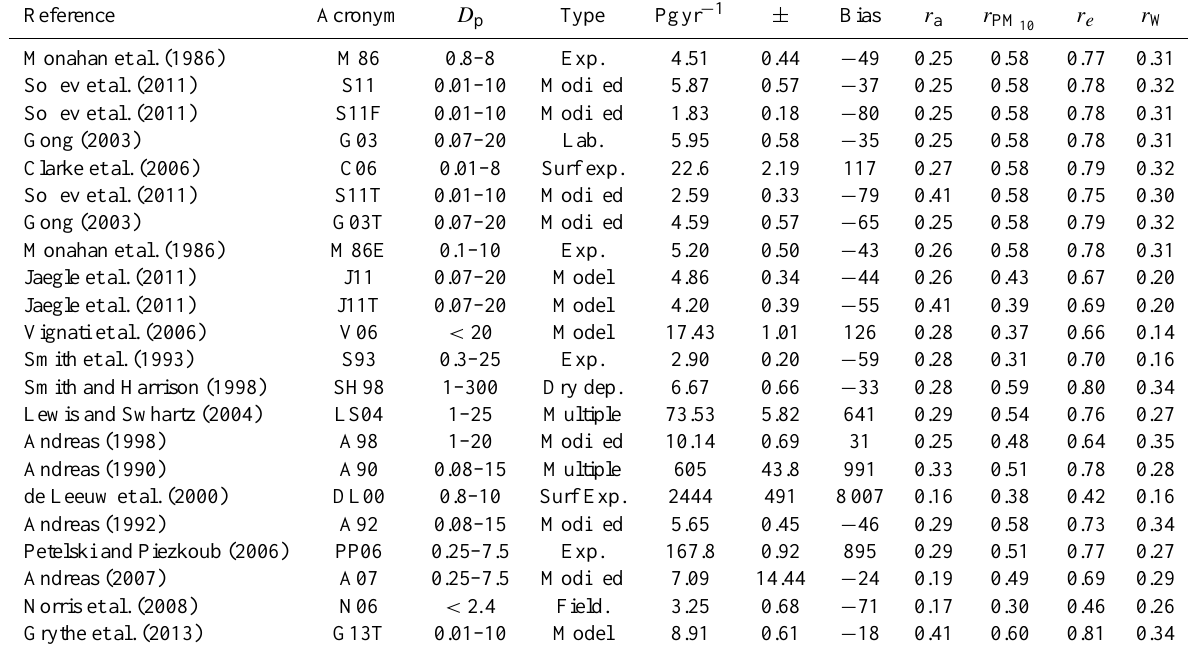
Table 2. List of all the source functions used in this paper. For sake of brevity, the acronym is used throughout the text. D p gives the validity size range in µm dry diameter. “Type” is the method that the authors have used to produce the source function. “Mean” is the annual average global production averaged over the 25yr of ECMWF data available, and “ ± ” is the difference in mass between maximum and minimum year, which is also given in Pg. “Bias” gives the relative bias in percent calculated for the modeled concentration compared to the mean of the combined PM 10 and EMEP measurements. Pearson’s correlation coefficient is reported for the entire data set ( r a ), for the PM 10 observations only, ( r PM ), for the EMEP data ( r e ), and for the week-long TSM measurements ( r W ). For the data subsets, the mean station correlation is 10 reported (and not, as for r a , the correlation for the set of data as a